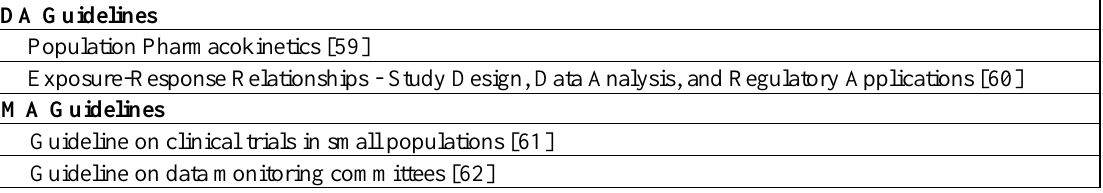
Table 6. Other guidelines with impact on pediatric drug